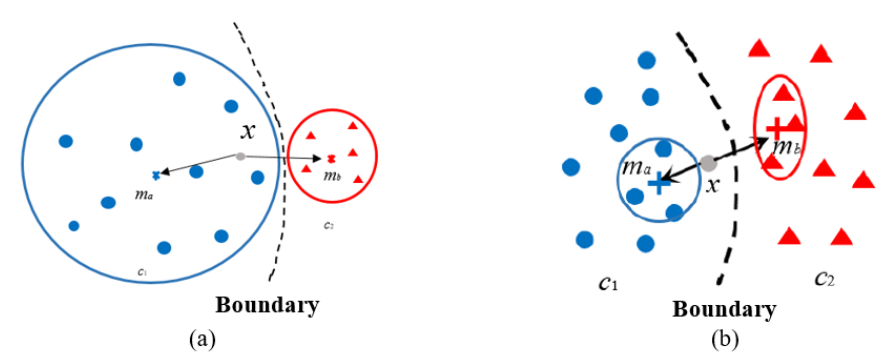
Figure 5. The third modification of DSA. ( a ) specific case. ( b )